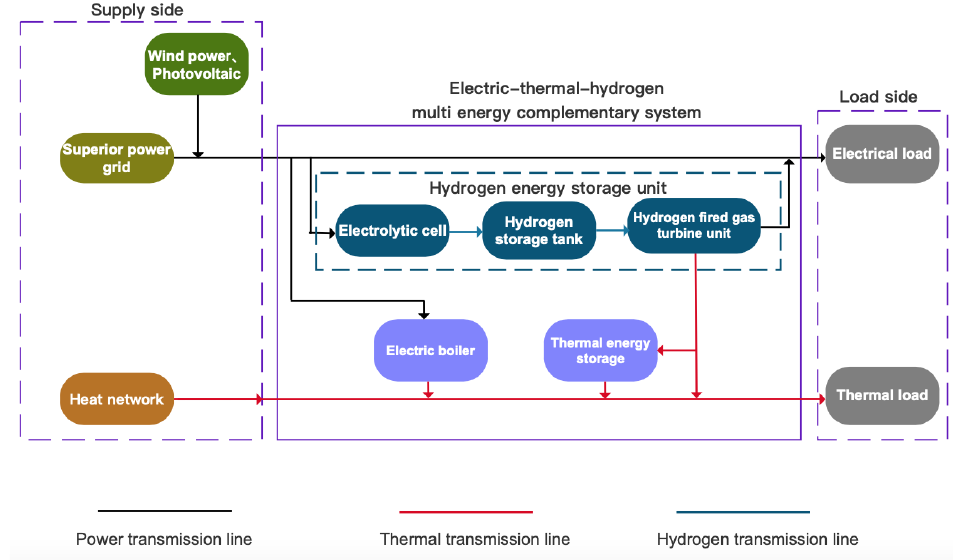
Figure 12. Electric thermal hydrogen multi energy complementary system.